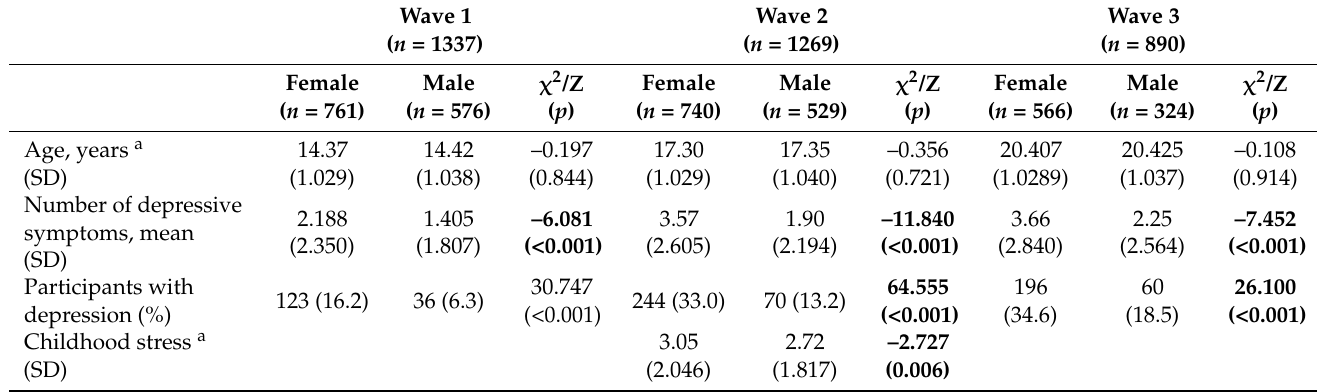
Table 1. Descriptive statistics for the study